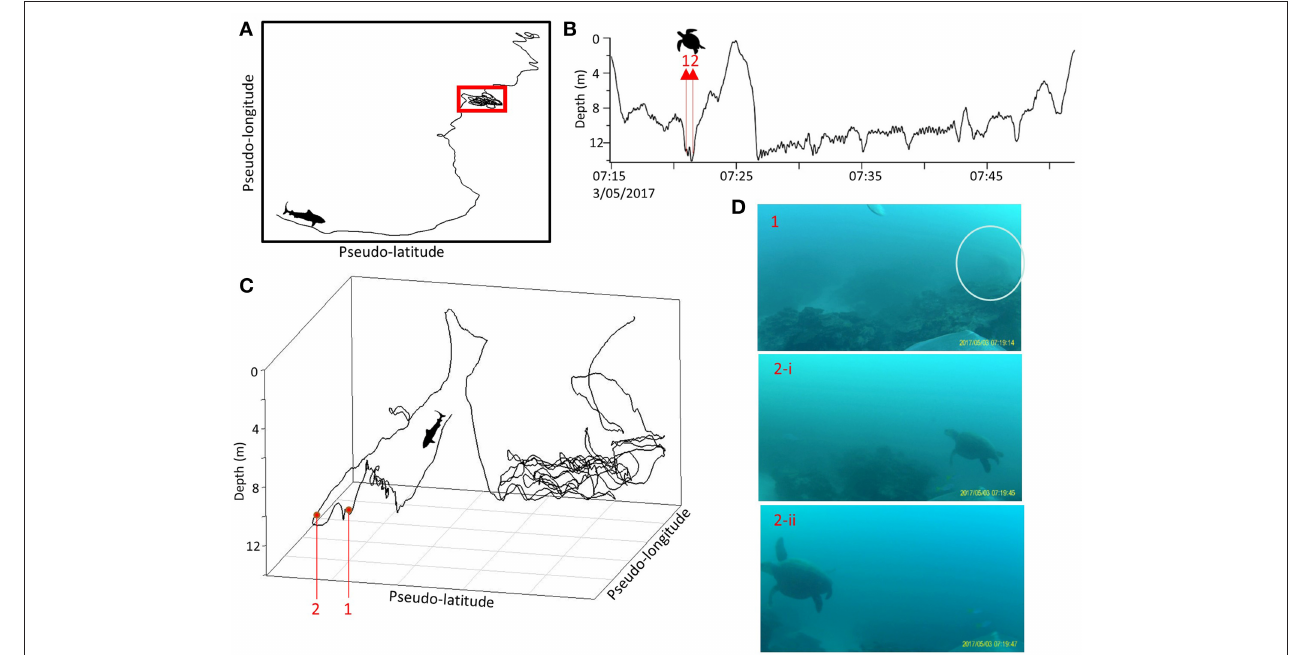
FIGURE 3 | Tiger shark and loggerhead turtle interaction. (A) One-hour long pseudo-track from TS15. Red square denotes 35min area of prey interaction displayed in (B,C) . (B) Depth track. (C) 3D track. (D) Screenshots from video of the interaction. 1 and 2 refer to where interaction takes place in depth and 3D tracks. See Supplementary Video 1 for full video of